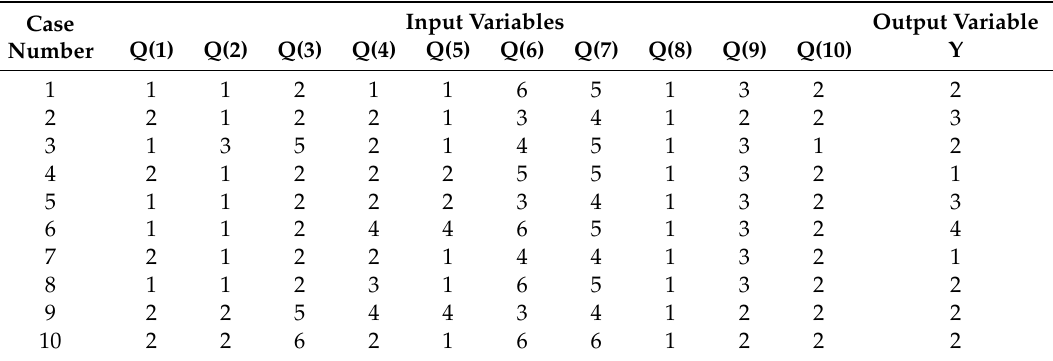
Table 4. Cases of input and output